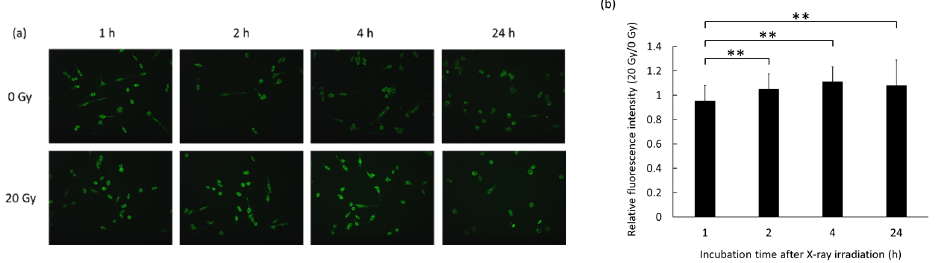
Figure 2. Production of intracellular reactive oxygen species (ROS) in RAW264 macrophages fol- lowing X-ray irradiation as assessed using the fluorescent probe hydroxyphenyl fluorescein (HPF). ( a ) Representative fluorescence images of cells treated with either 0 Gy or 20 Gy of X-rays over time. ( b ) Ratio of the fluorescence signals (20 Gy/0 Gy) at each respective time point. Statisti- cal significance was assessed using Scheffe’s test. Data are shown as mean ± standard deviation. ** p < 0.01.